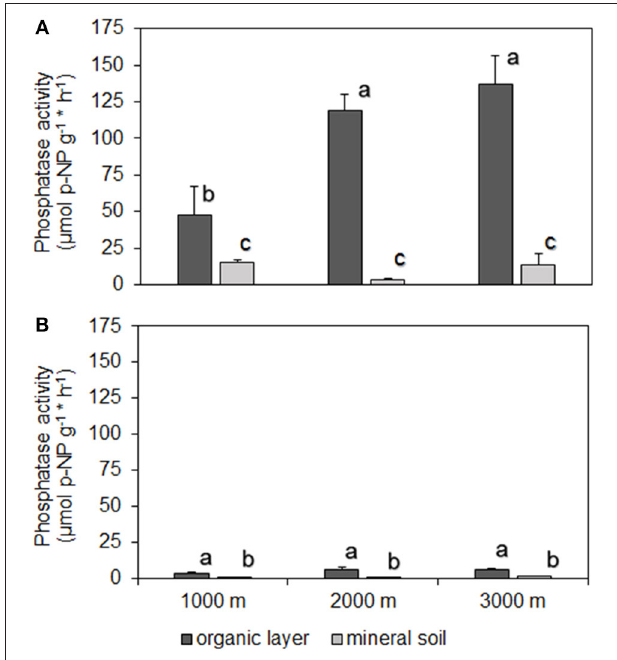
FIGURE 1 | Activities of phosphomonoesterases (A) and phosphodiesterases (B) (mean ± 1 SE) in organic layer and mineral topsoil (0–5cm) along the altitudinal gradient (1000–3000 m) of NUMEX. Significant differences between activities (univariate ANOVA, P < 0.05 ) are denoted with letters (a > b >